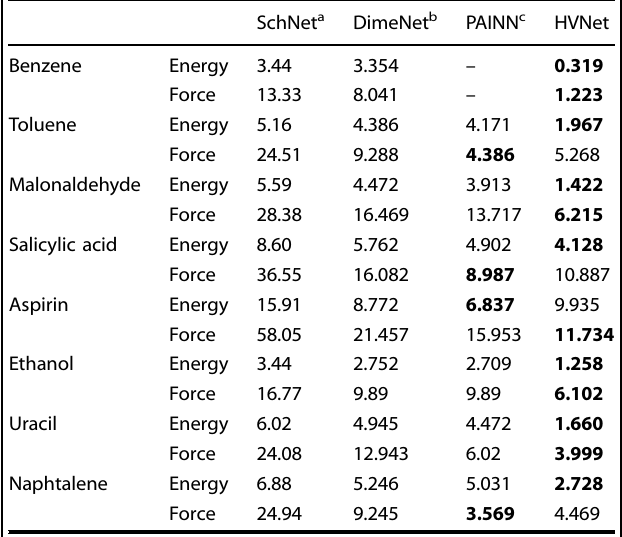
Table 1. Comparison of the MAEs between several benchmarked models and HVNet trained on MD17 dataset using 1000 training samples (energies in meV and forces in meV Å − 1